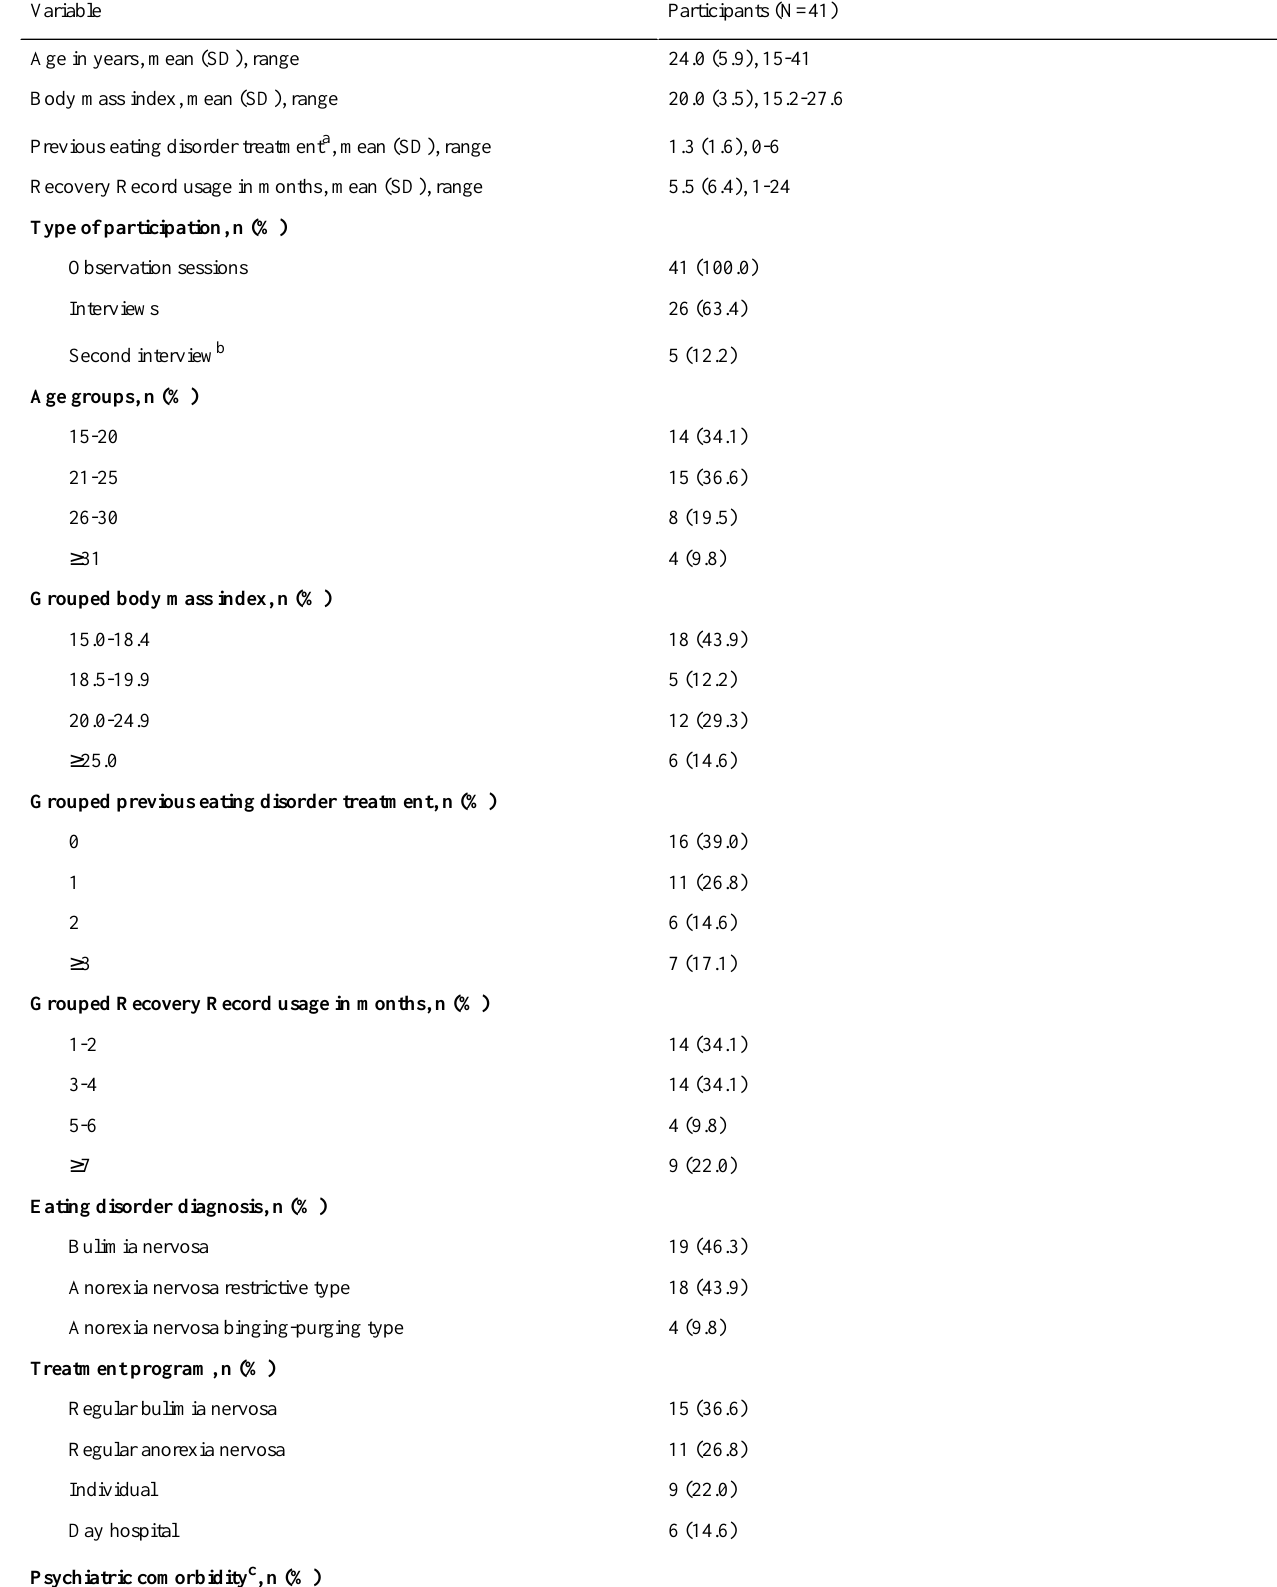
Table 3. Characteristics of participants. Data were collected at the time of the first interview or participant observation session (whichever came first) from self-report questionnaires and medical